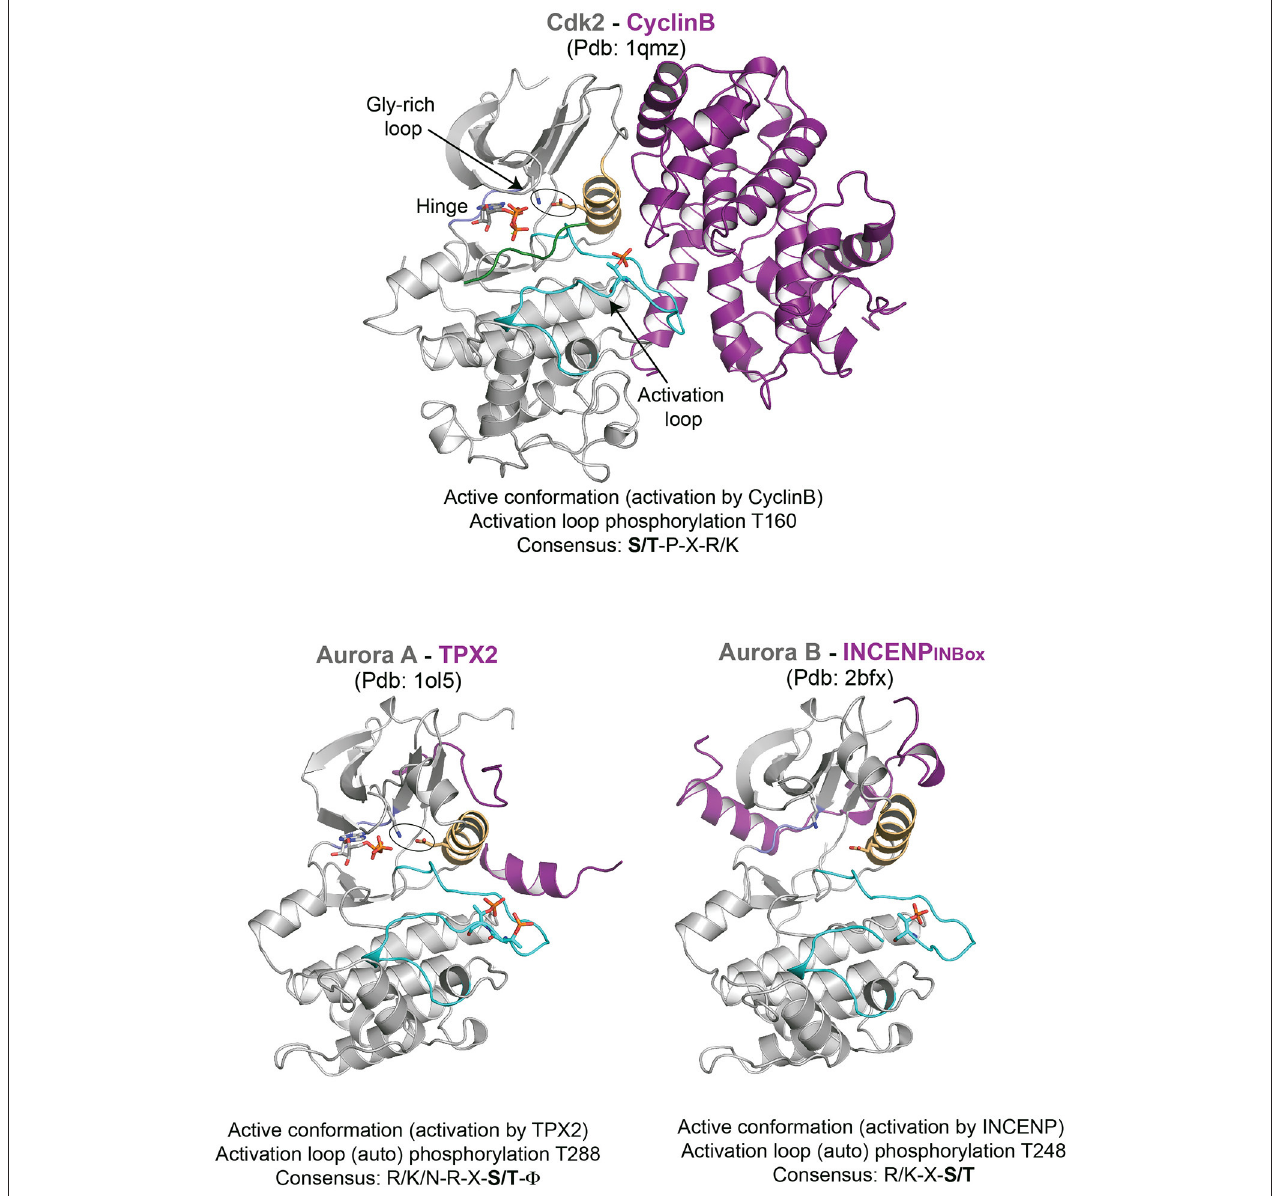
FIGURE 1 | Representative structures of mitotic kinases I. Key structural features are highlighted: C-helix (light orange), hinge region involved in ATP binding (blue), and activation segment (cyan). The characteristic structural feature of an active enzyme, the salt bridge between a Lys and Glu from the N-terminal lobe and the C-helix is highlighted in stick